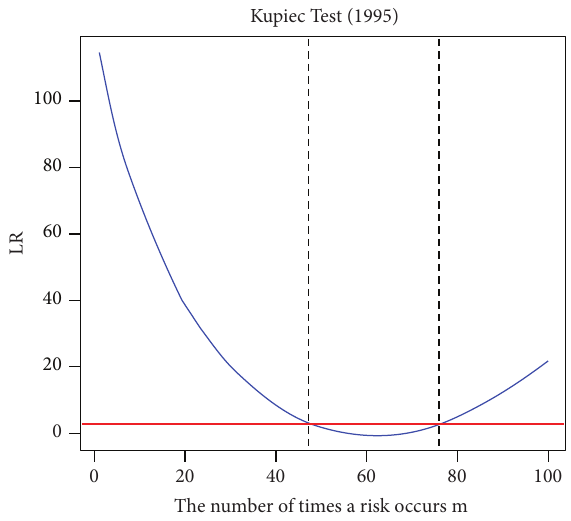
Figure 6: Interval chart of risk days at 95% confidence